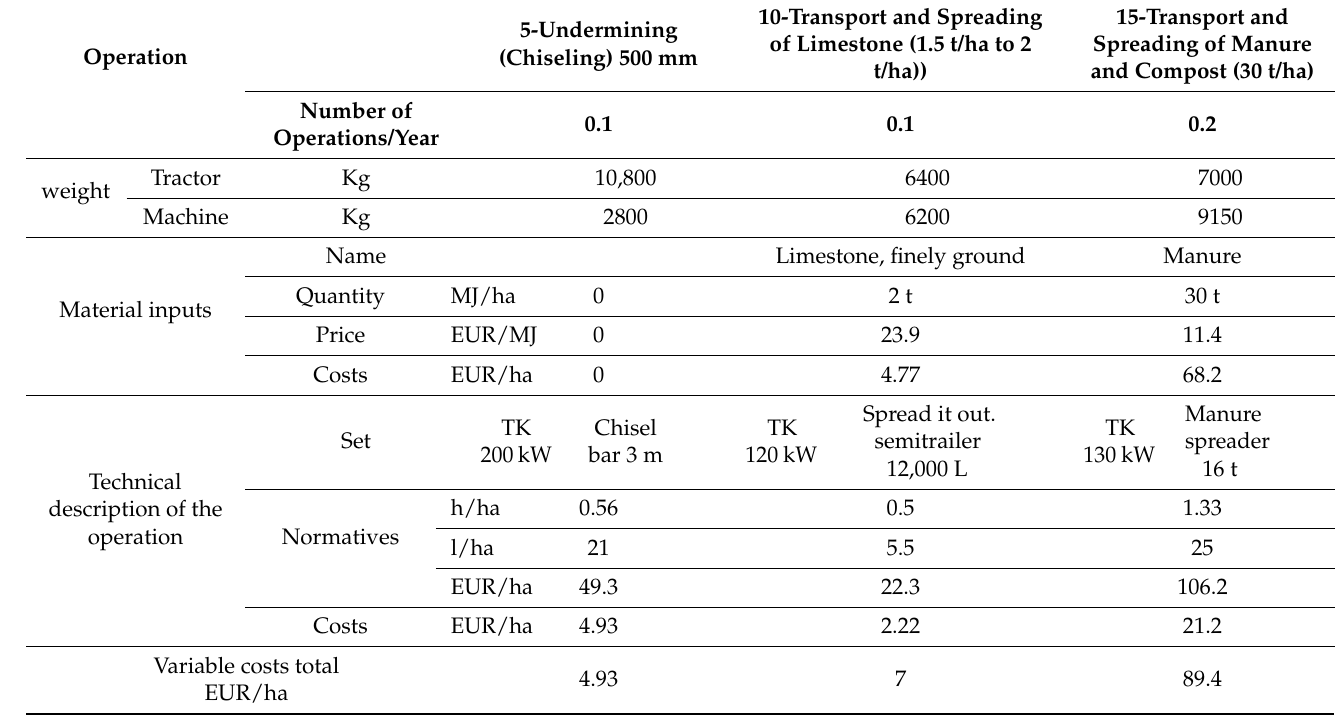
Table A1. The case of technological operations by soya.